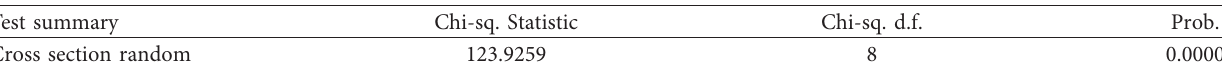
Figure 7: GFI in northwest China from 2004–2017. Table 6: Hausman test results.